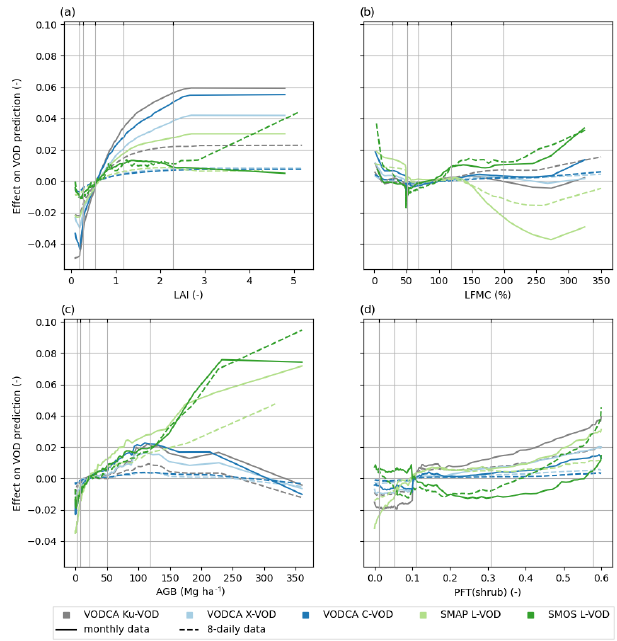
Figure 5. ALE plots of predicted normalized VOD with respect to ecosystem properties based on the global monthly or 8-daily RF model with the plant functional type (PFT) shrubland vegetation (shrub) as an example of the influence of land cover fractions on VOD. Vertical lines indicate the quantiles of the data sample sizes for 0.05, 0.25, 0.5, 0.75, and 0.95,